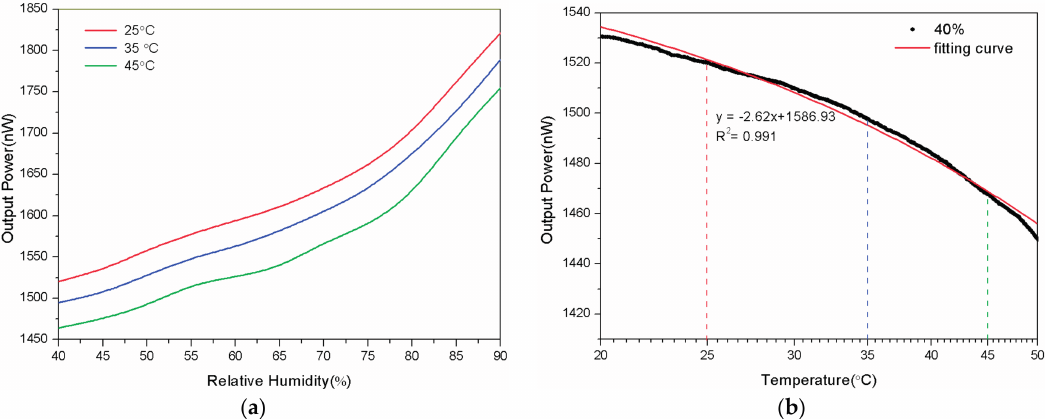
Figure 7. ( a ) The humidity response of the proposed sensor at 25, 35, and 45 ◦ C, respectively; ( b ) The temperature dependence of the sensor at an ambient humidity of